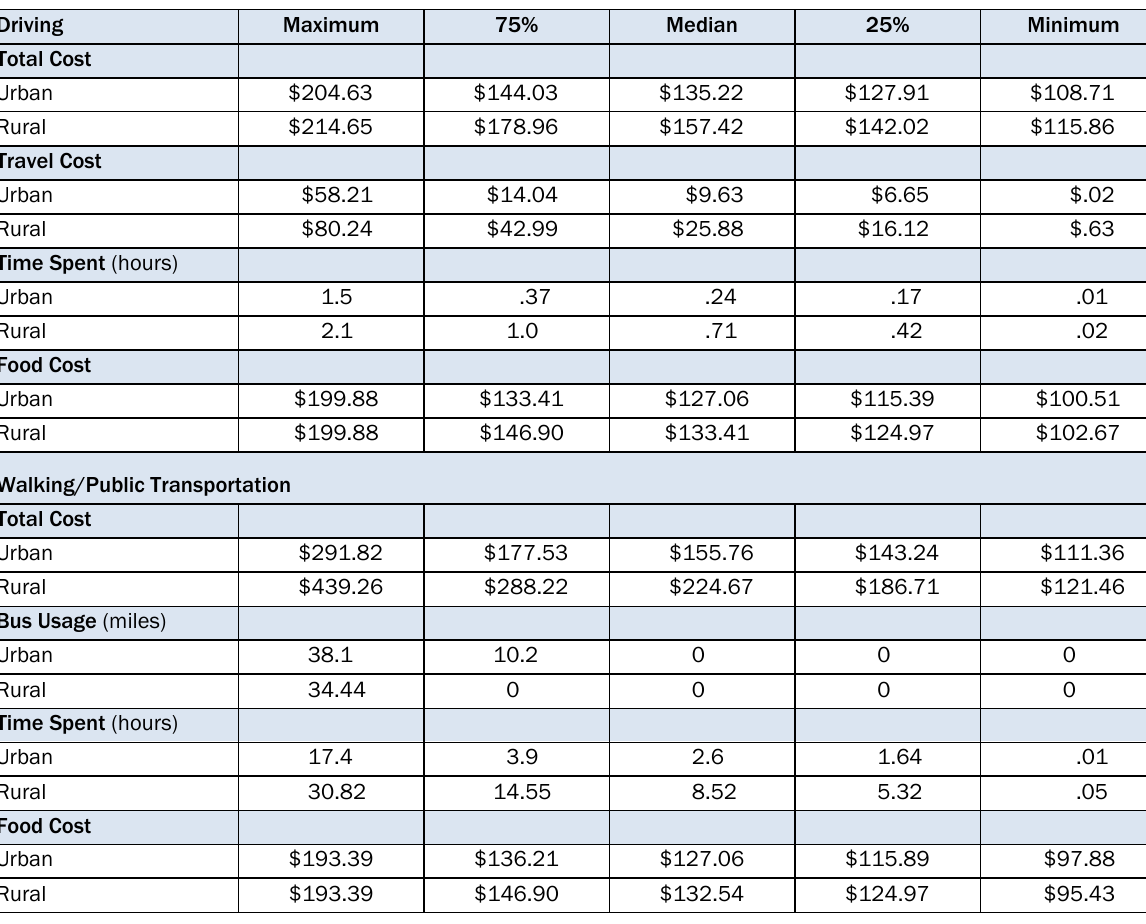
Table 1. Average minimum costs of the USDA Thrifty Food Plan in rural and urban areas in the Gulf Coast Counties of Mississippi during spring 2011, considering both the cost of the food items and the cost of transportation to acquire them (all costs in